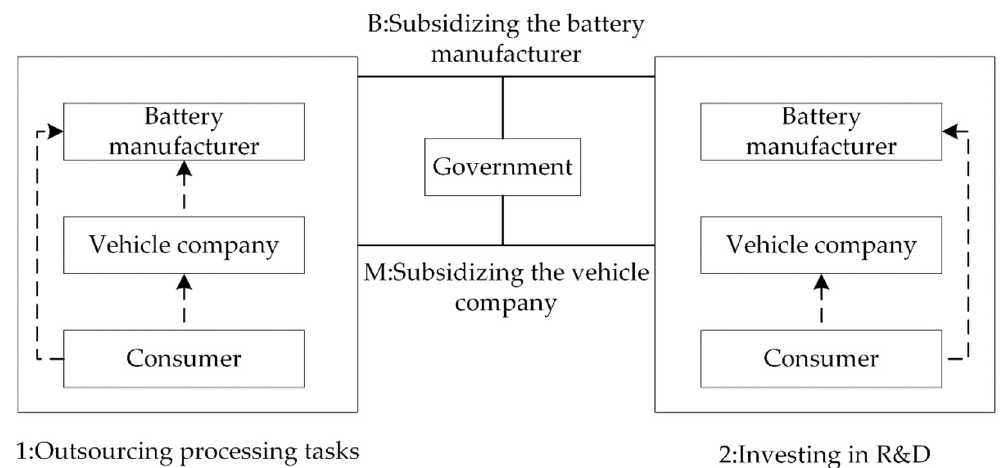
Figure 1. The influence of different government subsidy strategies on the vehicle company’s decision-making in processing waste batteries.